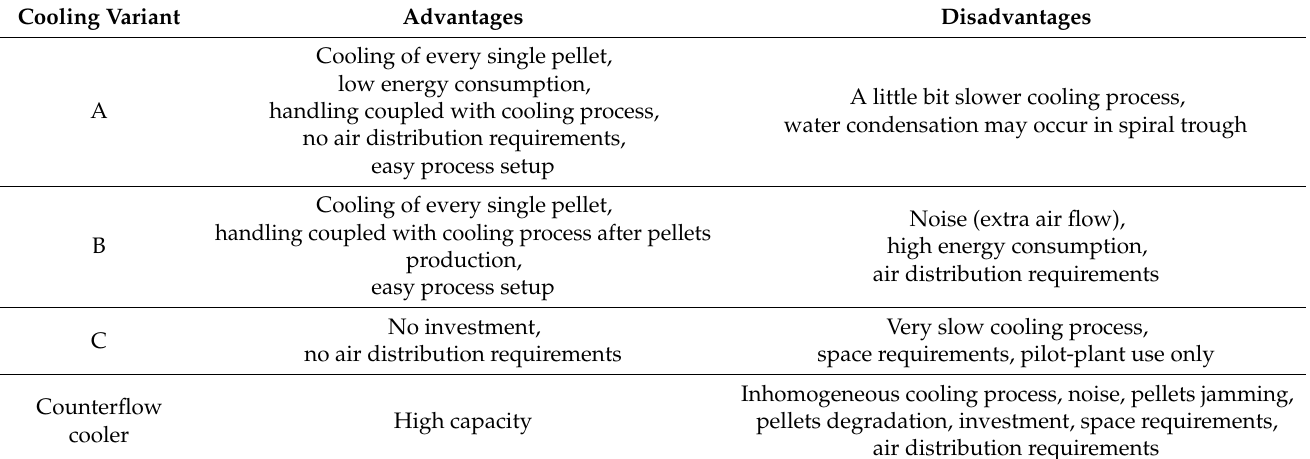
Table 3. Various cooling systems